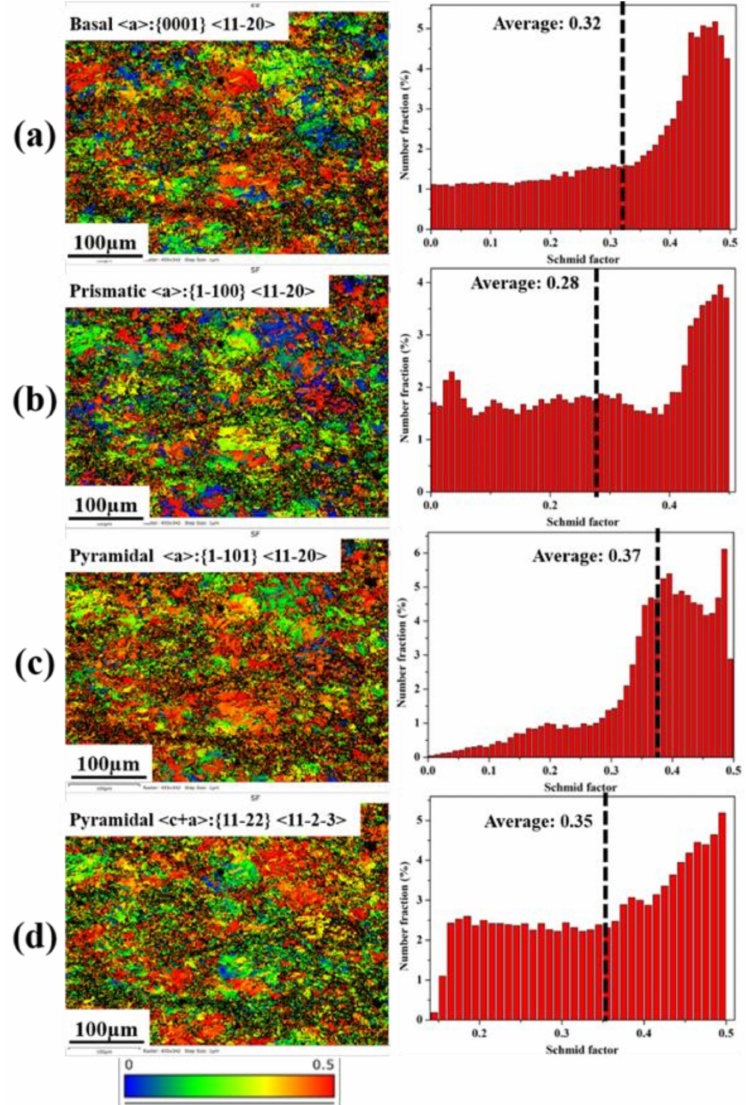
Figure 7. SF maps and corresponding distribution histograms for various slip systems of MDIF100+100 sample of GW52 alloy: ( a ) basal slip <a>:{0001} <11–20>, ( b ) prismatic slip <a>:{1–100} <11–20>, ( c ) pyramidal slip <a>:{1–101} <11–20>, ( d ) pyramidal slip <c+a>:{11–22}